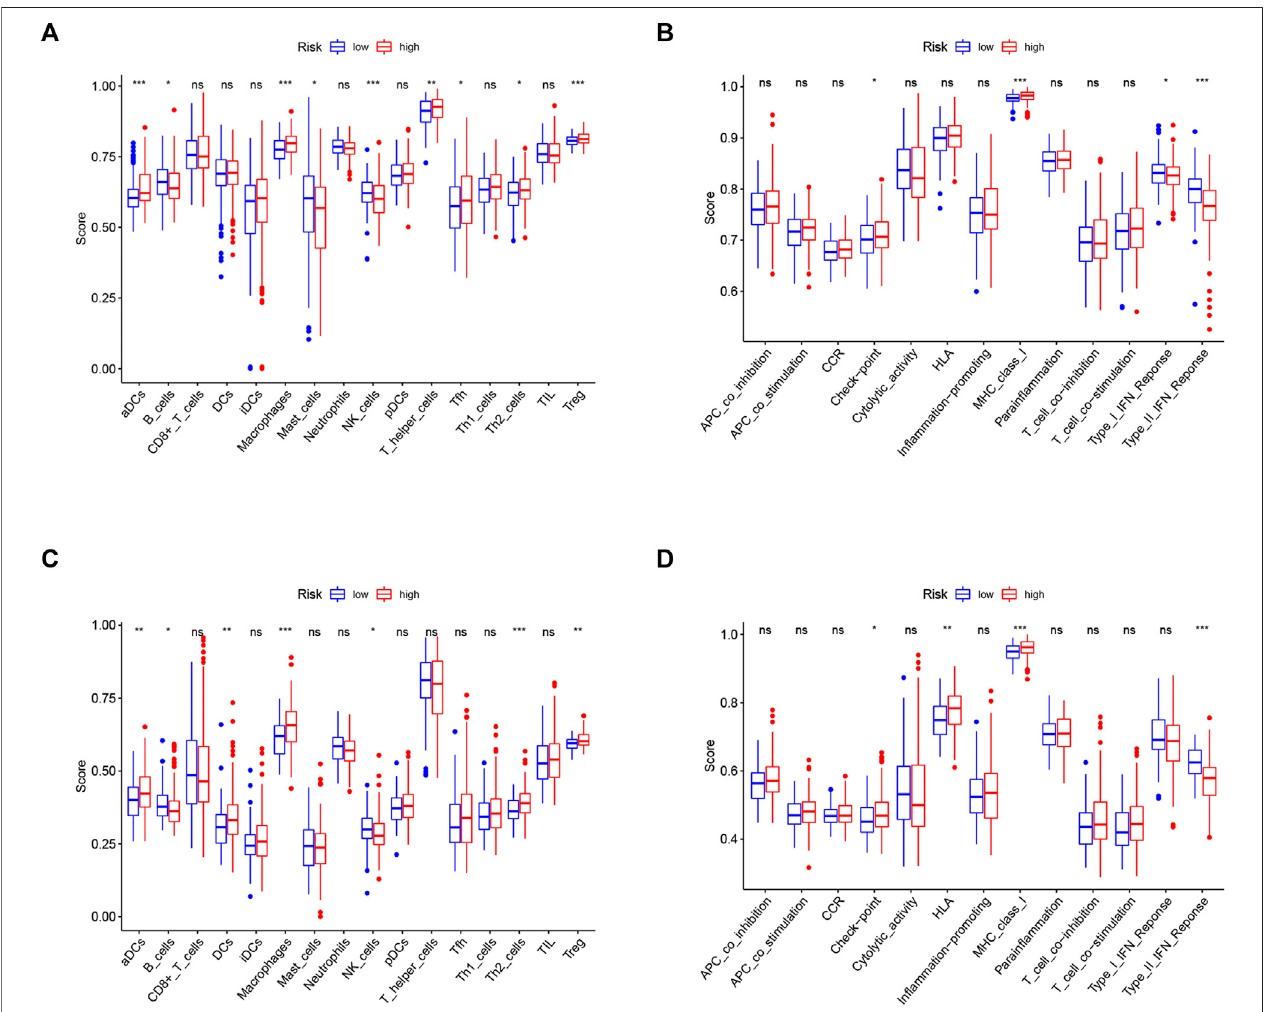
FIGURE 8 | Comparison of the ssGSEA scores between different risk groups in the TCGA cohort (A,B) and ICGC cohort (C,D) . The scores of 16 immune cells (A,C) and 13 immune-related functions (B,D) are displayed in boxplots. CCR, cytokine – cytokine receptor. Adjusted p values were shown as ns, not signi fi cant; *, p < 0.05; **, p < 0.01; and ***, p <